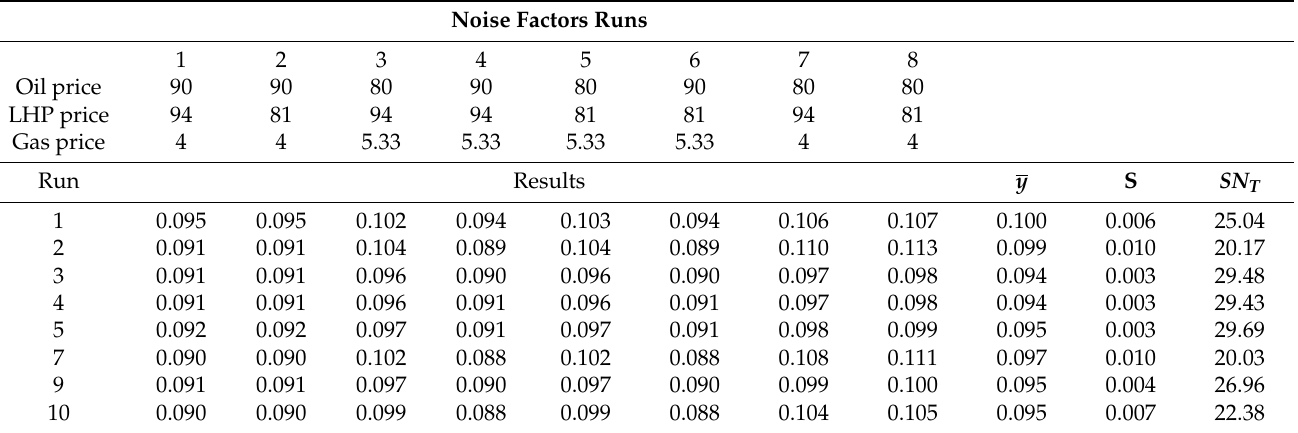
Table 6. Results for the first 10 runs for